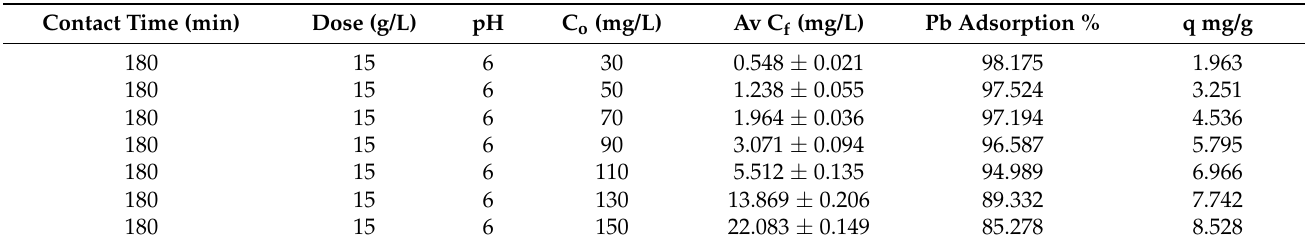
Table 5. Effect of initial concentration of adsorbate on Pb (II) removal efficiency of Odaracha adsorbent (agitation speed = 150